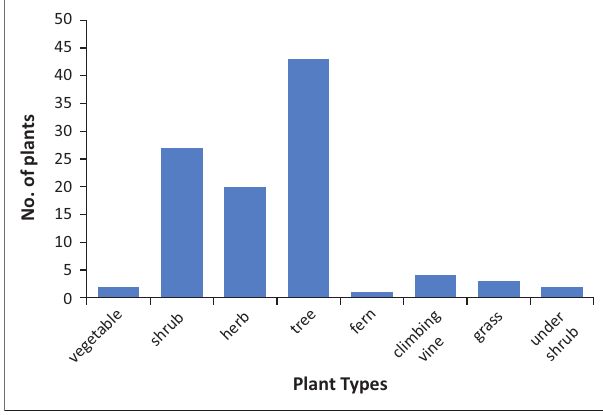
FIGURE 2: Distribution of Plant types in Otuo, Owan East Local Government Area, Nigeria. Plants with medicinal uses summed up to 80 (Table 1) and are used to treat a host of ailments. Medicinal plants used to treat stomach pain and cough were the most abundant followed by those used in treating rheumatism, skin infection, fever, gonorrhoea and diabetes (Figure